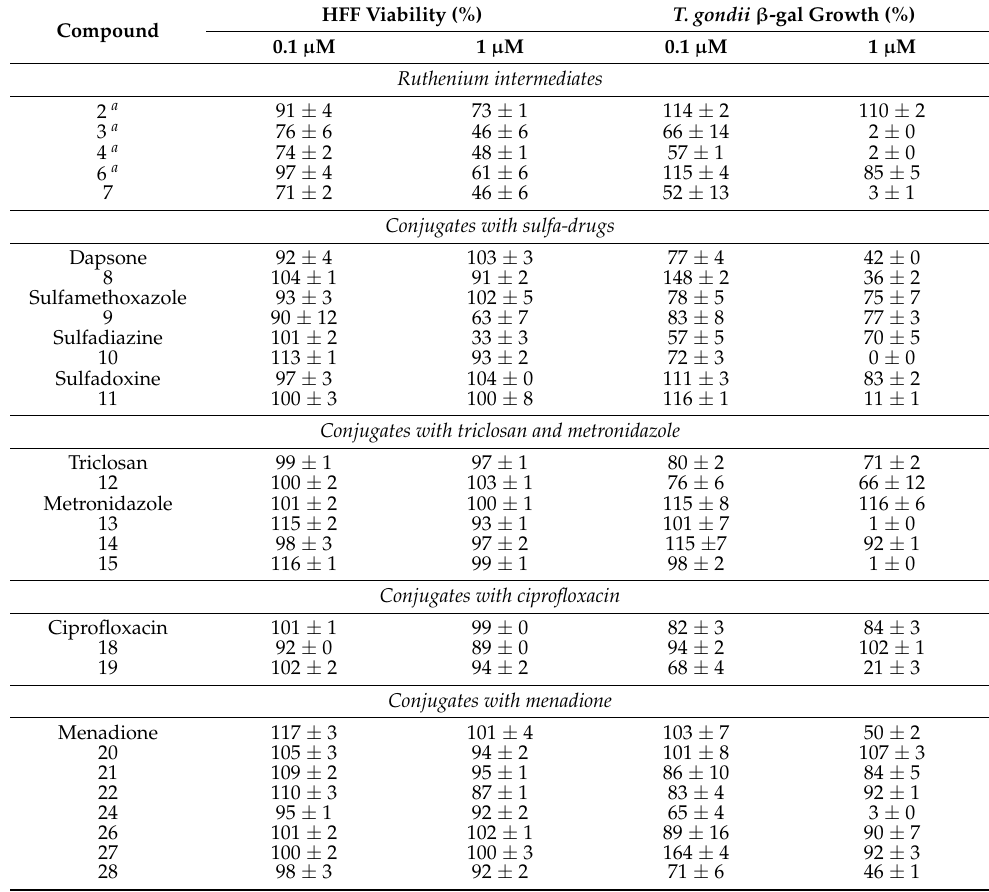
Table 4. Cytotoxicity/efficacy screening of compounds in noninfected HFF cultures and T. gondii β -gal tachyzoites cultured in HFF. Tests were realized in triplicate. The values of the compounds selected for determination of IC 50 values against T. gondii β -gal are highlighted in